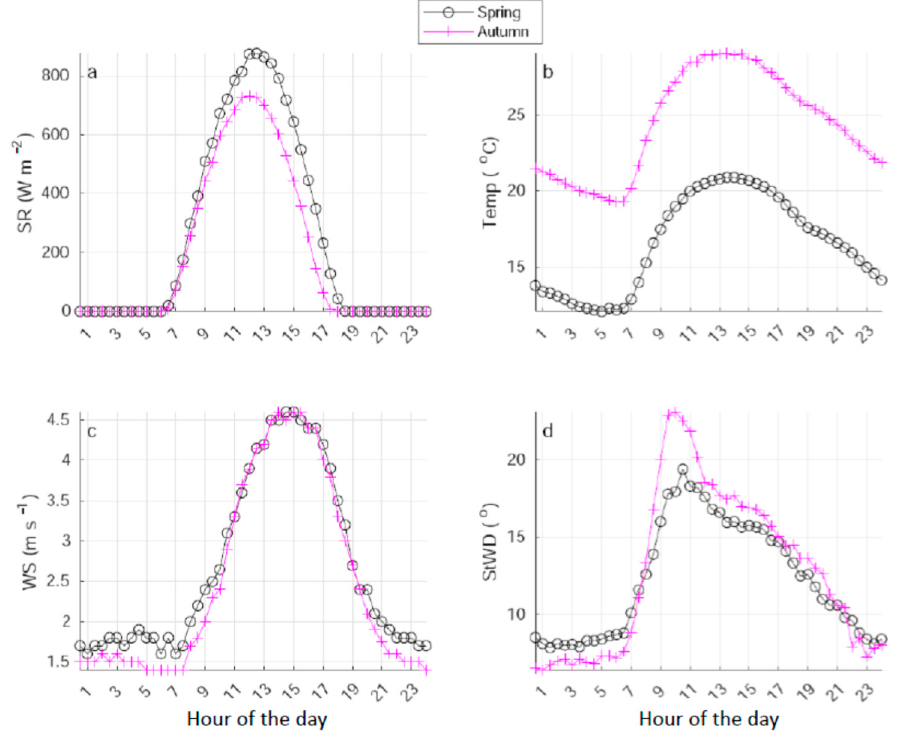
Figure 5. Daily cycles of meteorological variables, averaged over five working days before and after the spring and autumn DST clock changes in 2000–2020. The meteorological variables, ( a )—solar radiation (SR), ( b )—temperature (Temp), ( c )—wind speed (WS) and ( d )—standard deviation of the wind direction (SWD), were observed at the Bet Dagan meteorological station, which is located at the center of the study area (Figure 1).